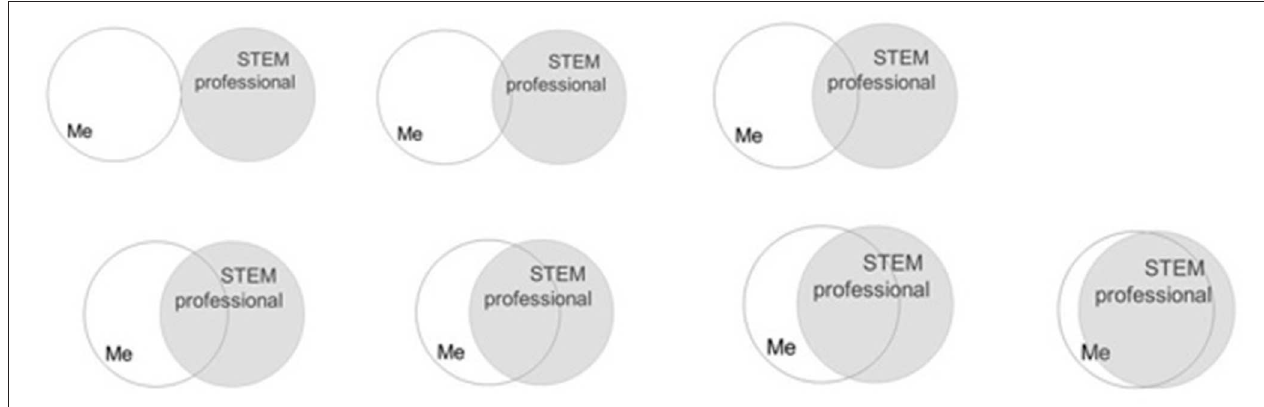
FIGURE 1 | STEM Professional Identity Overlap Measure . Participants were instructed to select the picture that best describes the current overlap of the image they have of themselves and their image of what a STEM professional is.